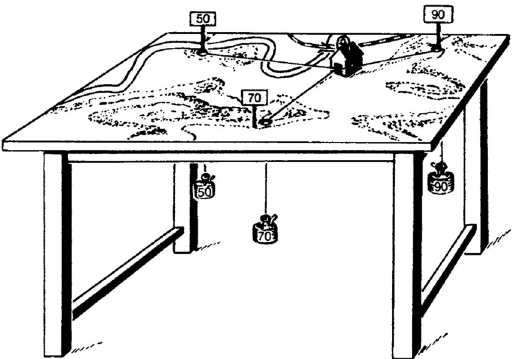
Fig. 2 An example for physically solving computational problems. There are three villages with 50, 70 and 90 elementary school students living in each village. How can we minimise the total distance travelled for all students' to school when we build an elementary school? The answer is the centre of gravity (as to where the elementary school should be built). This fi gure was reprinted with the permission of the copyright holder, the Oxford University Press. H. Steinhaus: Mathematical Snapshots, Oxford Univ. Press (1960).